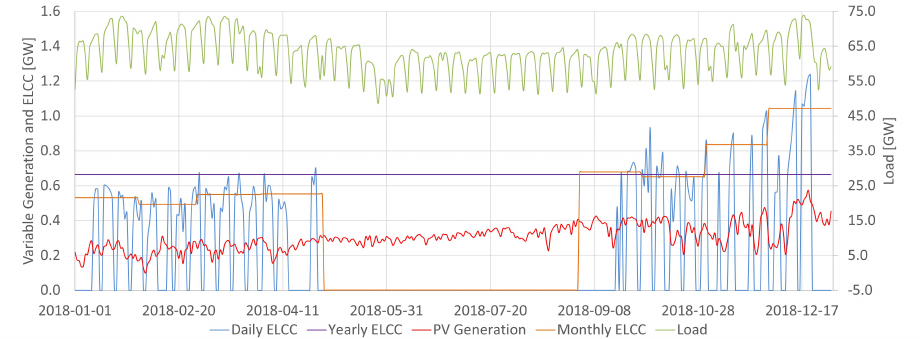
Figure 8. Daily, monthly and yearly ELCC for PV power in 2018 for the SIN.